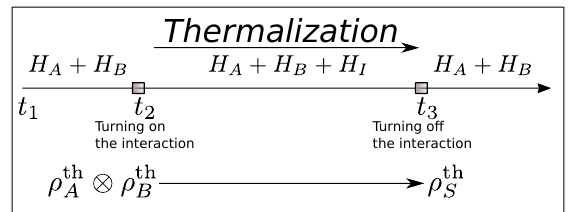
Figure 1. This figure illustrates the phases of the thermalization protocol, as described in the